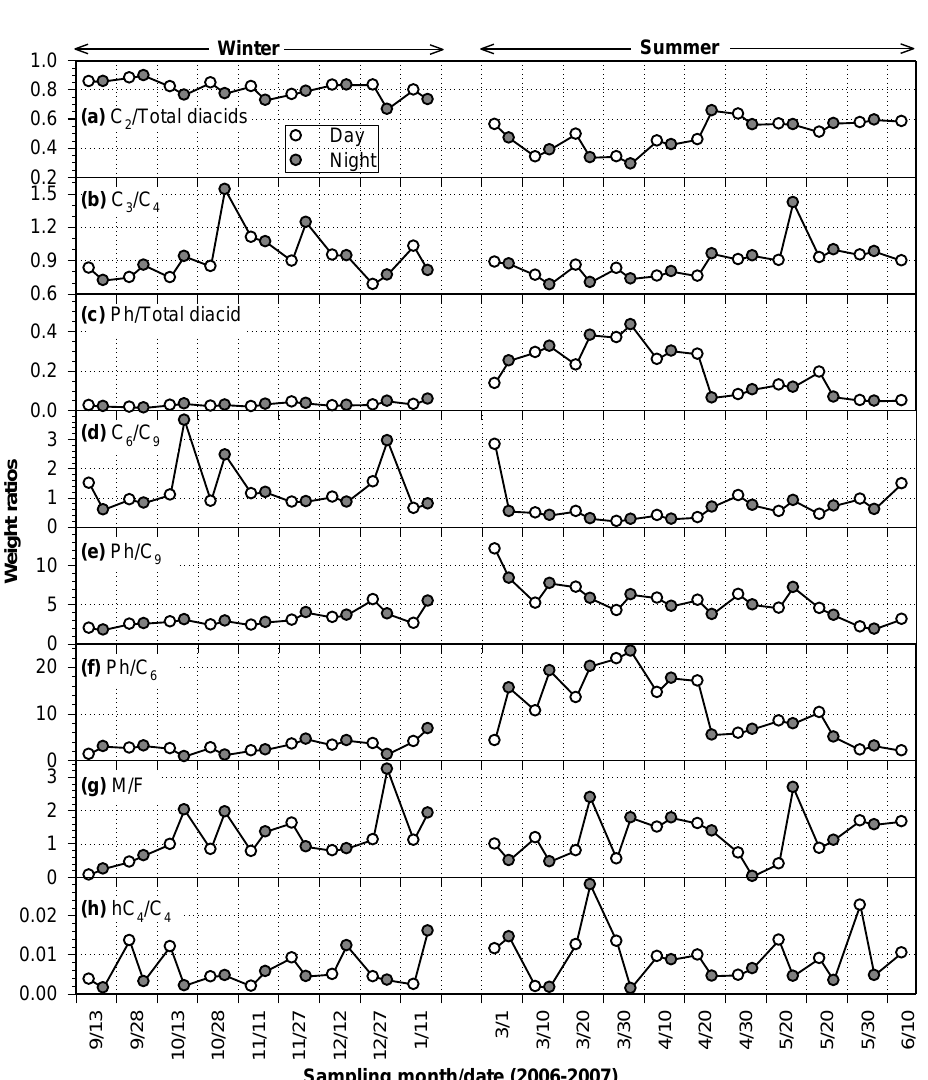
Fig. 9. Temporal variations in concentration (weight) ratios of (a) C 2 /total diacids, (b) C 3 /C 4 , (c) Ph/total diacids, (d) C 6 /C 9 , (e) Ph/C 9 , (f) Ph/C 6 , (g) M/F and (h) hC 4 /C 4 in aerosol samples collected at Nainital,